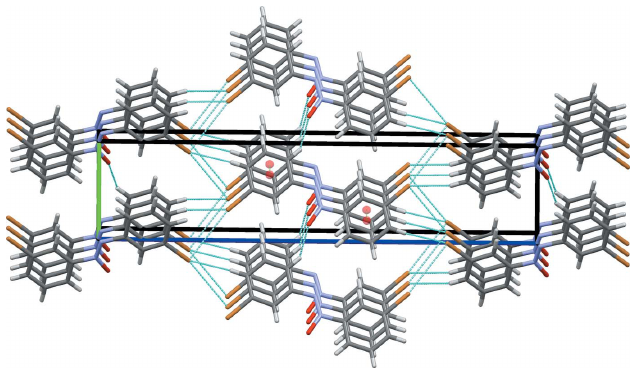
Figure 3 Overall packing of (I) viewed along the a- axis direction. Representative (cid:2) – (cid:2) contacts are shown as dotted green lines with ring centroids drawn as red spheres.